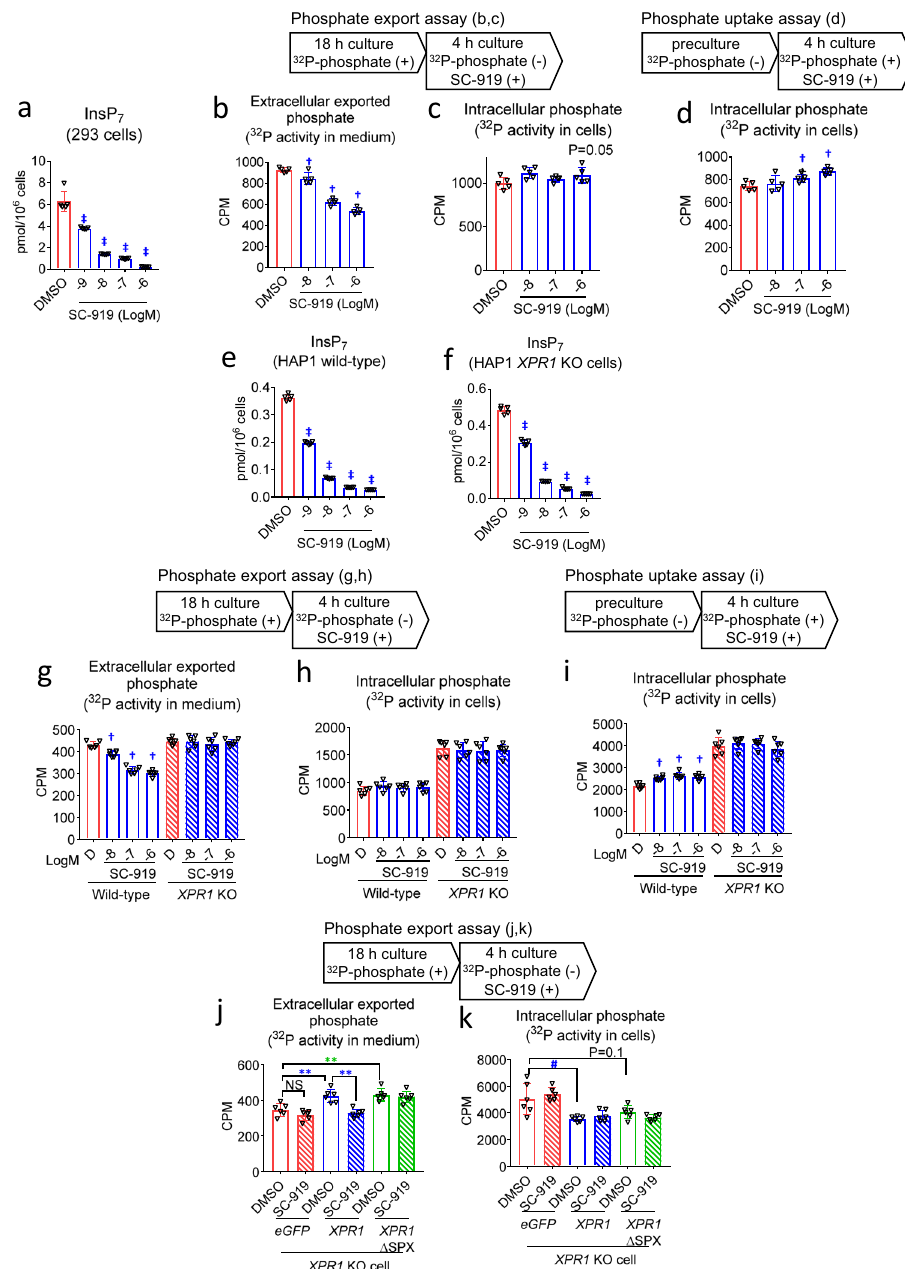
Fig. 2 IP6K inhibition reduces the export of phosphate via an XPR1 -dependent mechanism involving the SPX domain. Effect of treatment with SC-919 for 4 h on the a intracellular InsP 7 levels in 293 cells, b exported extracellular 32 P activity, and c intracellular 32 P activity in the phosphate export assay in 293 cells, d intracellular 32 P activity in the phosphate uptake assay in 293 cells, e, f Levels of InsP 7 in HAP1 wild-type and XPR1 KO cells, g levels of exported extracellular 32 P activity, and h intracellular 32 P activity in phosphate export assay in HAP1 wild-type and XPR1 KO cells, i intracellular 32 P activity in phosphate uptake assay in HAP1 wild-type and XPR1 KO cells, j, k Exported extracellular 32 P activity and intracellular 32 P activity in phosphate export assay in XPR1 KO cells introduced with either eGFP , XPR1 , or inositol pyrophosphates-binding site-deleted XPR1 ( XPR1 Δ SPX) treated with either DMSO or SC-919 (1 μ M). Values indicate mean ± S.D. ( n = 5 biological replicates for a – f and 6 biological replicates for g – k ). † P < 0.05 and ‡ P < 0.05 vs. vehicle as determined using Williams ’ test and Shirley – Williams test, respectively. ** P < 0.01 as determined using Student ’ s t -test, and # P < 0.05 as determined using the Aspin – Welch test. D, DMSO. CPM, counts per